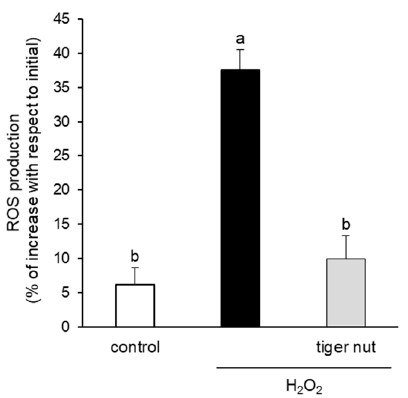
Figure 7. Effect of tiger nut on ROS production in Caco ‐ 2 cells incubated with H 2 O 2 . Cultures were incubated for 3 h in the absence (control) or presence of H 2 O 2 (350 μ mol/L) and tiger nut (2.5 mg/mL). Results are expressed as the mean ± SEM of n = 16 monolayers. Labeled bars without a common letter differ ( p < 0.05).